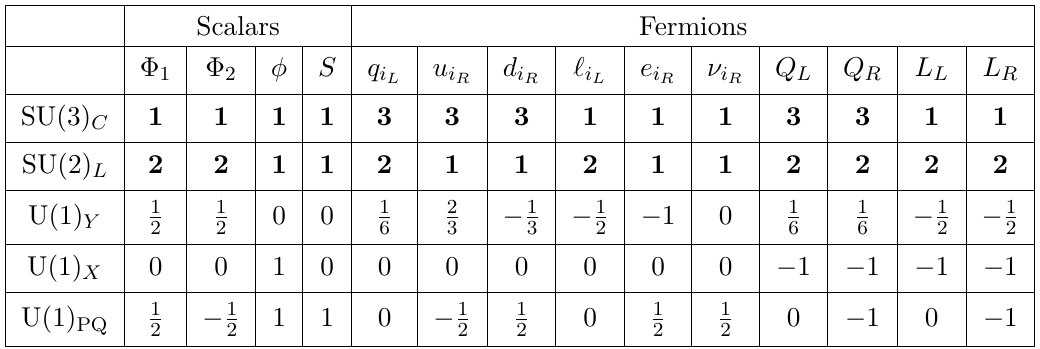
Table 1 . The particles and their charges under SU(3) C × SU(2) L × U(1) Y × U(1) X × U(1) PQ in our